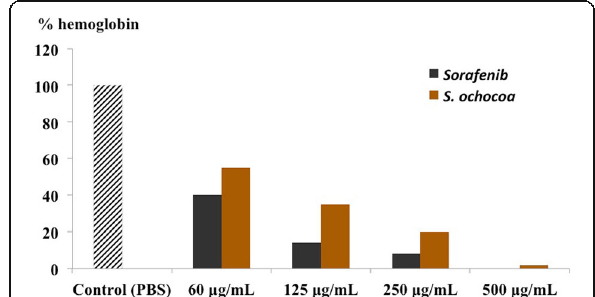
Fig. 3 Haemoglobin content of CAM sections detected by Drabkin ’ s assay. The hemoglobin content in the CAM sections was determined by Drabkin method. As in the case of macroscopic observation of CAM that showed that the number of blood vessel branches was concentration dependent, so the present figure shows a hemoglobin content dependent on the concentration of S.